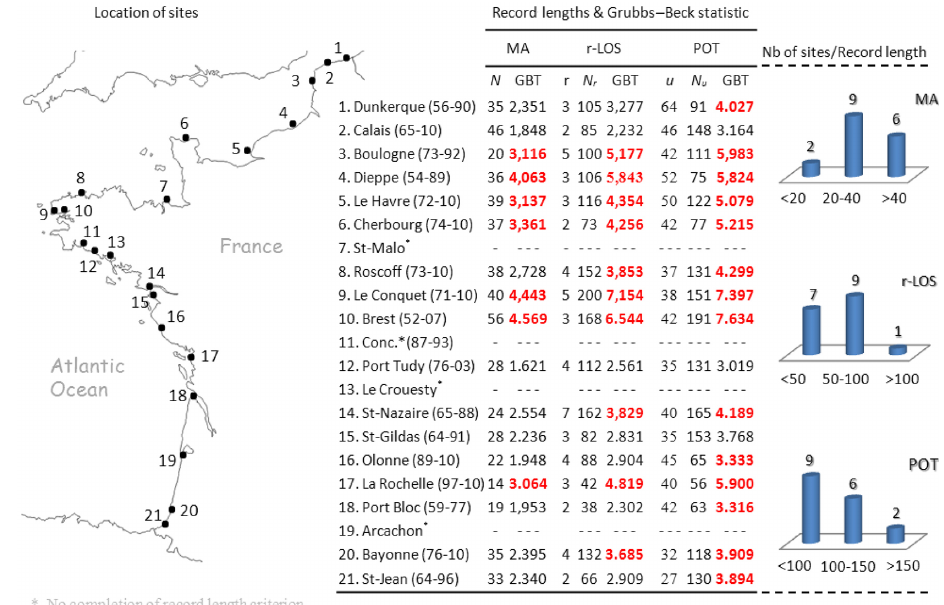
Figure 1. To the left: location of sites. In the middle: a table containing the site names and periods of records, the record lengths and the Grubbs–Beck statistic (GBT) of each site and for the annual maxima (AM), the peaks-over-threshold (POT) and the r -largest order statistics ( r -LOS) methods. The r (the r -largest observations) and u (threshold – cm) values are also presented in this table. To the right: distribution of record lengths.